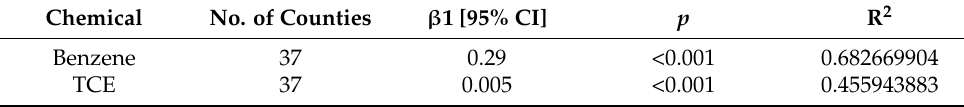
Table 7. Estimates of the linear regression parameters for benzene and trichloroethylene (TCE).